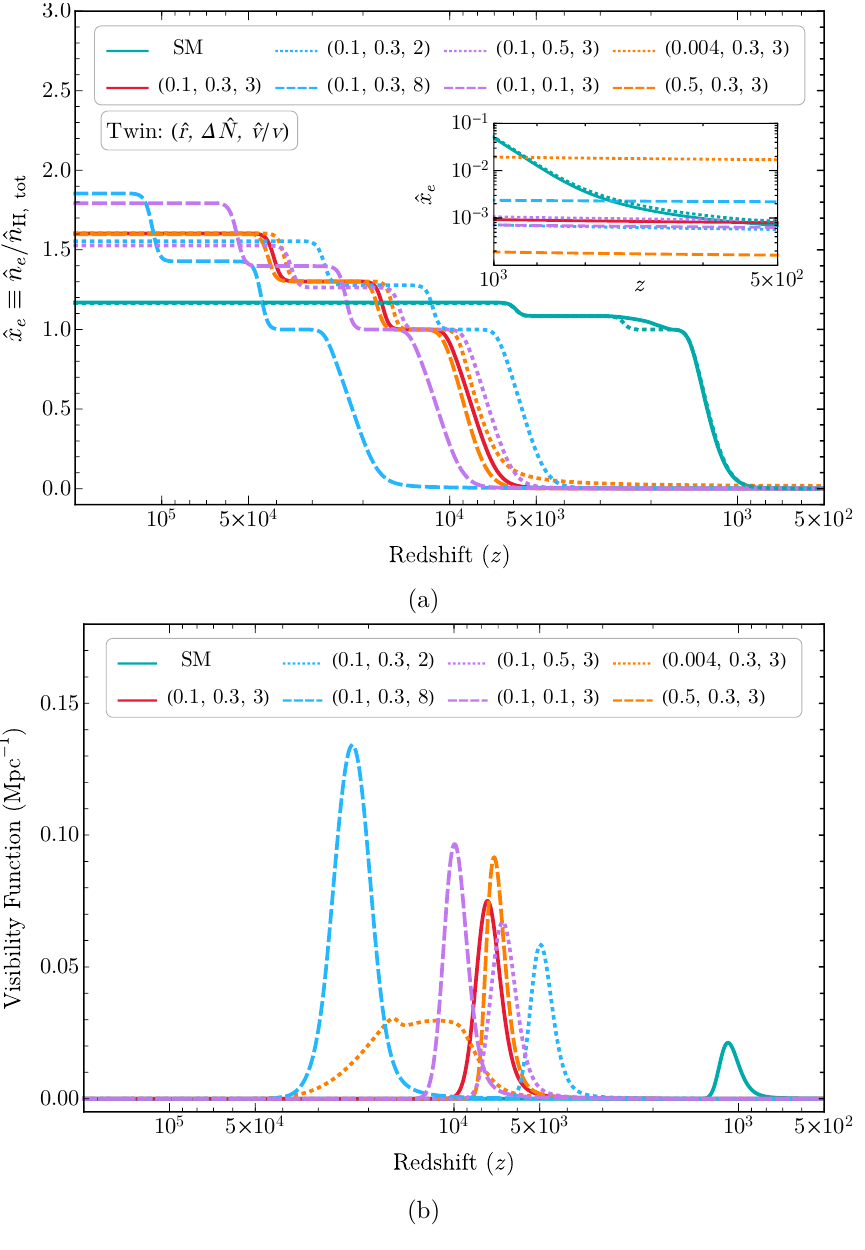
Figure 4. The ionization fraction (figure 4(a)) and visibility function (figure 4(b)) for Λ CDM and the MTH model with various twin parameters labelled according to (ˆ r , ∆ ˆ N , ˆ v/v ) . The y -axis corresponds to x for the Λ CDM e